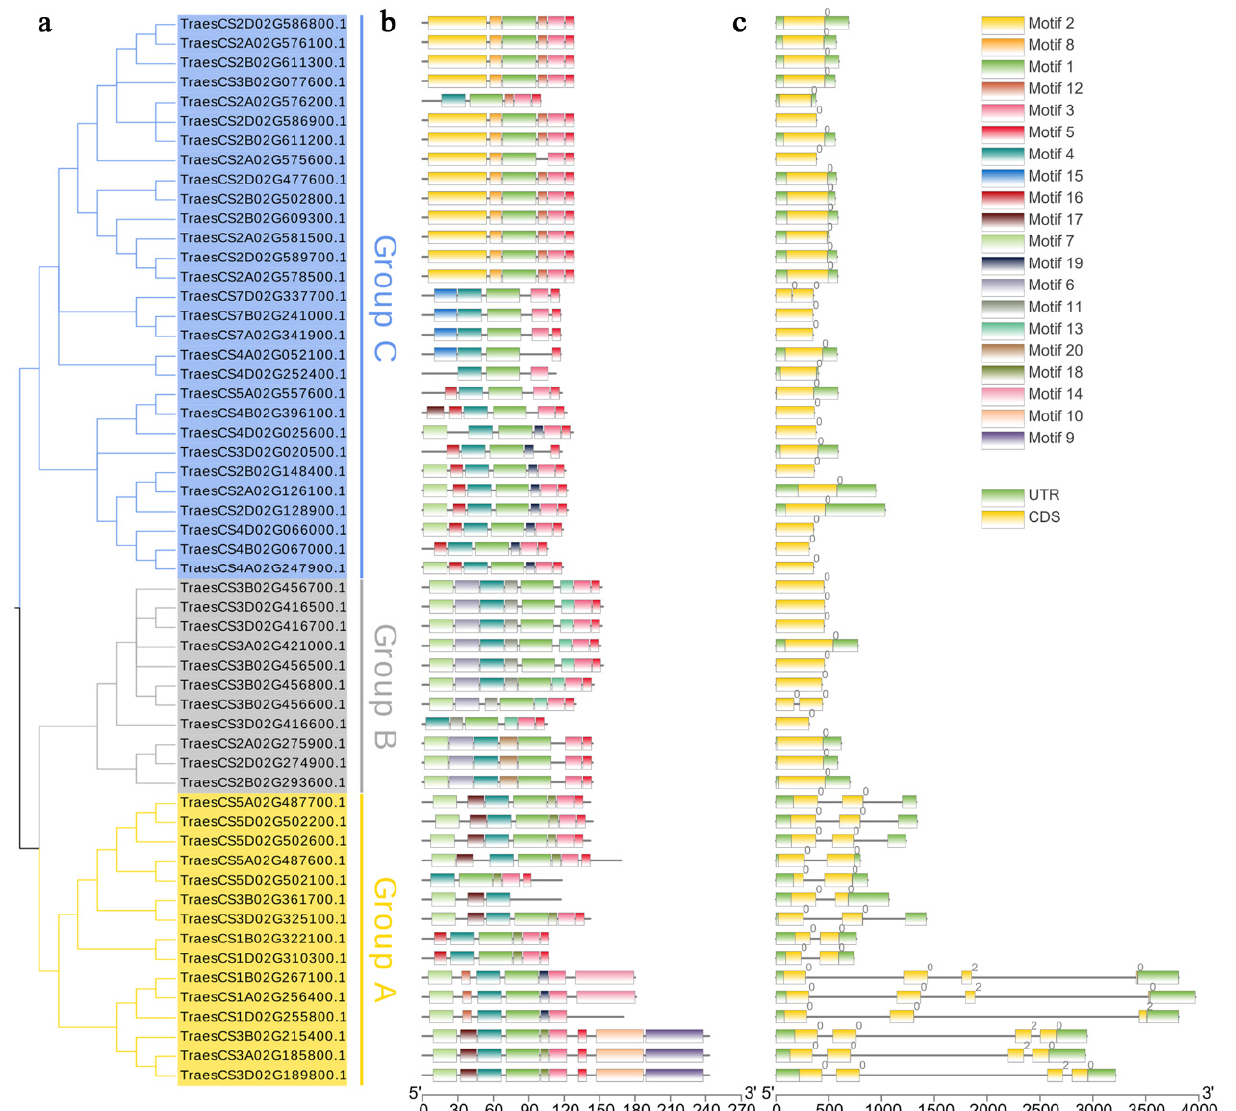
Figure 6. Phylogenetic relationship, gene structure, and motif composition analysis of TaCystatins. ( a ) Phylogenetic tree of TaCystatins. The ML tree was built on the basis of the full-length amino acid sequences of TaCystatins using MEGA X, with a set of 1000 replications. All TaCystatins members were divided into three phylogenetic groups. ( b ) Architecture of the conserved protein motifs of TaCystatins. Different motifs numbered 1 to 20 are indicated by different colors. ( c ) Intron/exon structures analysis of TaCystatins . Untranslated regions (UTRs) are represented by green boxes, introns are represented by gray lines, and the coding sequences (CDS) of exons are indicated by yellow boxes.